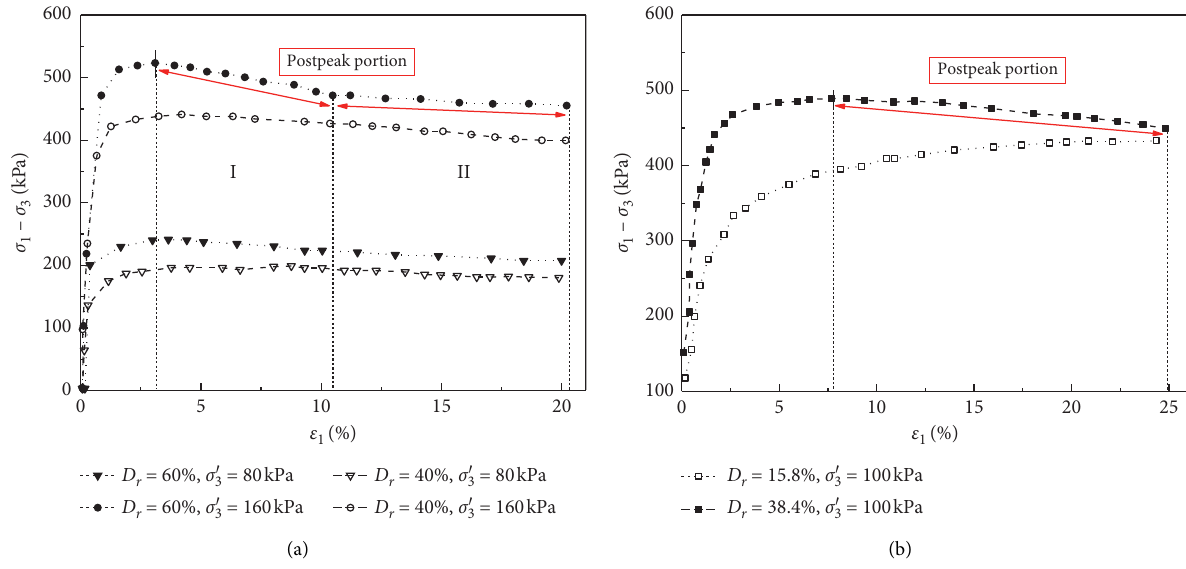
Figure 7: Stress-strain curves of sand at drained compression (data from [44]). (a) Nevada sand. (b) Toyoura sand.